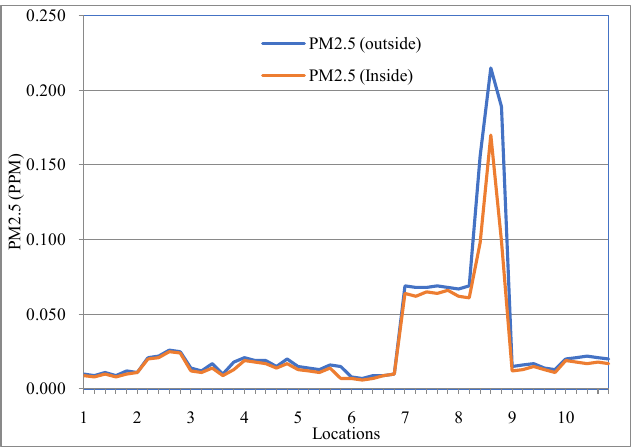
Fig. 6: Monitored PM2.5 Concentrations Inside and Outside of Houses 10 Locations in the Study Area